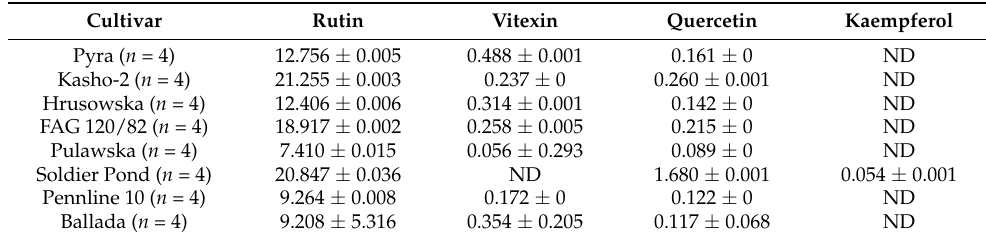
Table 4. Content of flavonoids in flowers of investigated buckwheat cultivars (mg/g d.w., means ± standard deviations of four independent determinations).